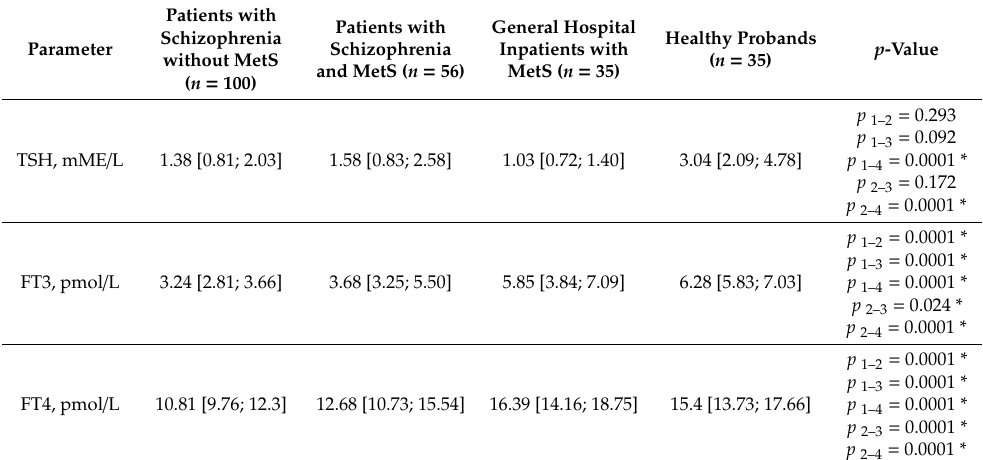
Table 2. Thyroid-stimulating hormone (TSH) and thyroid hormones (THs) levels.